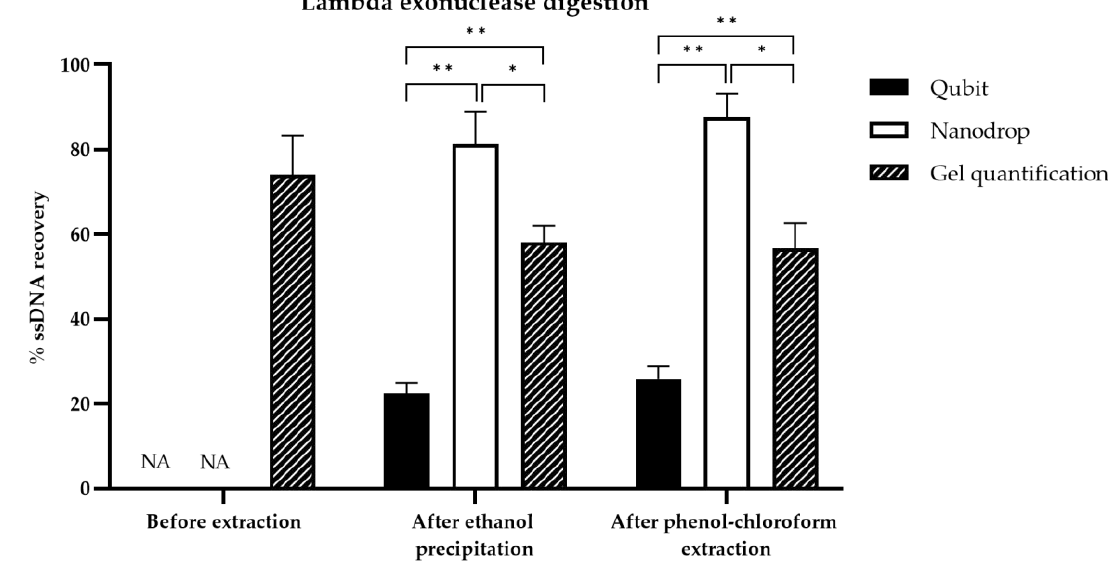
Figure 6. Histogram of ssDNA recovery quantified by Qubit, Nanodrop or gel quantification for lambda exonuclease digestion before and after two types of purification. The three ssDNA quantifica- tion techniques were compared in a peer comparison by Student’s statistical test. Asterisks represent significant differences according to Student’s t test (*: threshold of 0.01 or **: threshold of